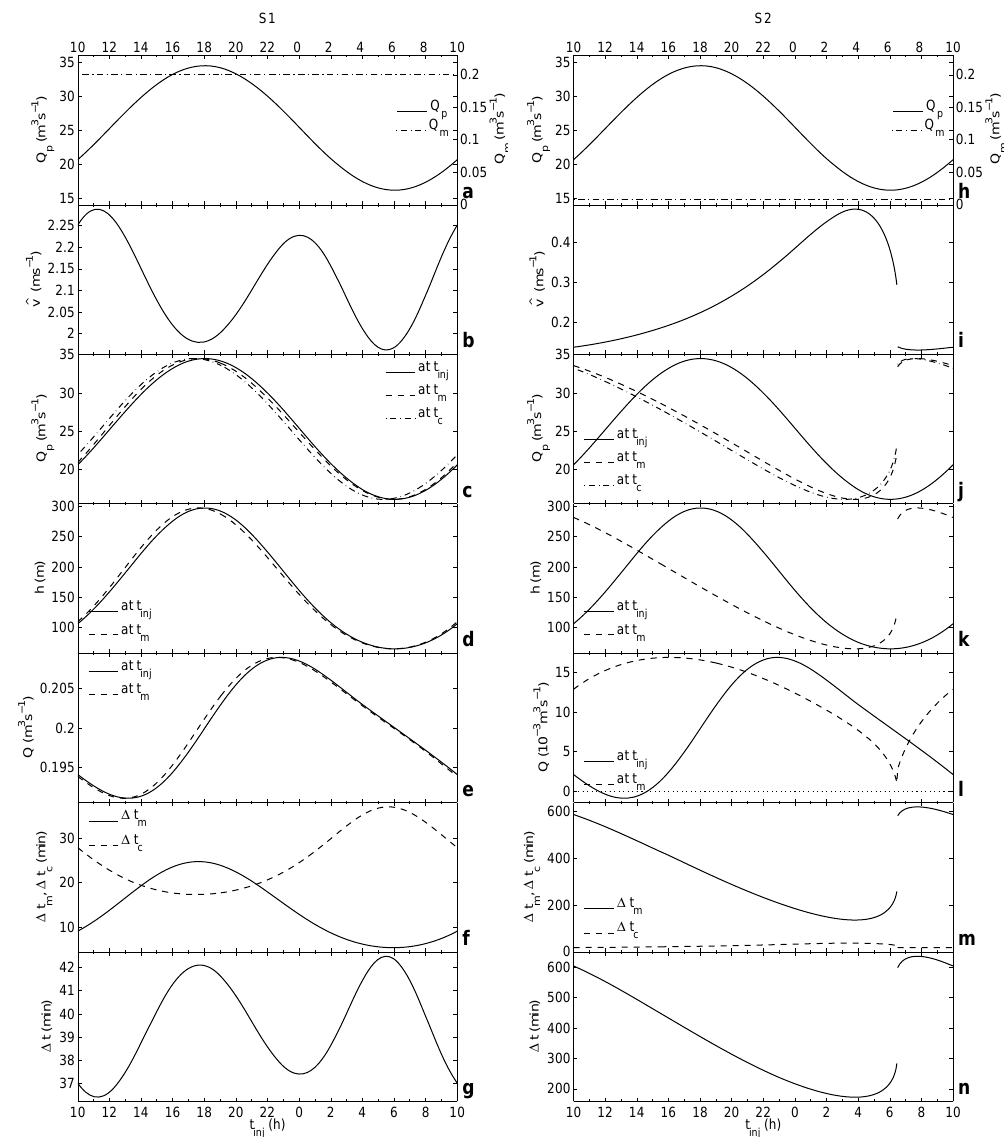
Fig. 7. The model input and output variables against injection time t inj from running the model with synthetic data: left panels (a) – (g) , model run S1 with Q m =0.2m 3 s − 1 and right panels (h) – (n) model run S2 with Q m =0.008m 3 s − 1 . The layout is identical to Fig. 5.